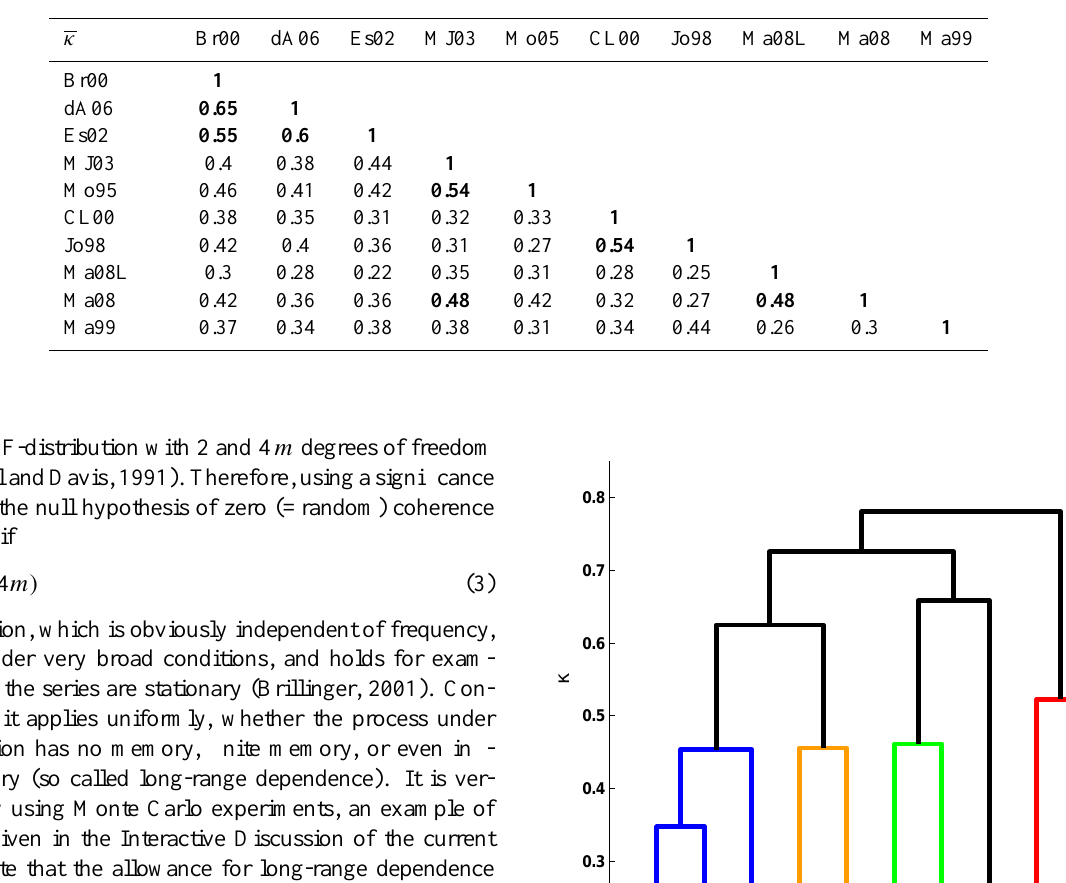
Table 2. Mutual coherence κ between millennial (1000 to 1850) reconstructions, averaged over frequencies ≥ 5y. Significant values ( κ ≥ 0.47 as the 99% level) are highlighted.